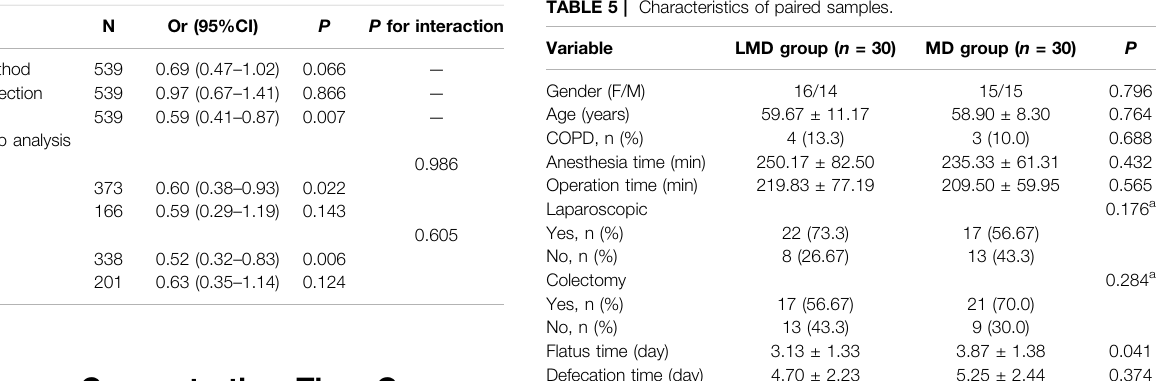
TABLE 4 | Logistic regression and subgroup analysis of LMD and POGD.